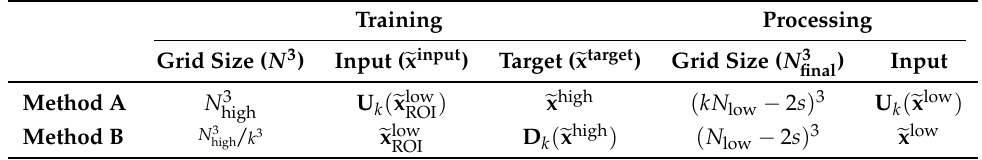
Table 1. An overview of the grid sizes of method A, where the input is up-sampled, and method B, where the target is down-sampled. The grid size and input are tabulated for the training phase and the processing phase, in which the final output is calculated. The grid size is in number of voxels. The processing grid size is the size of the output (cid:101) x final when the network is applied to (cid:101) x low , and s is the number of additional input slices that the network takes as